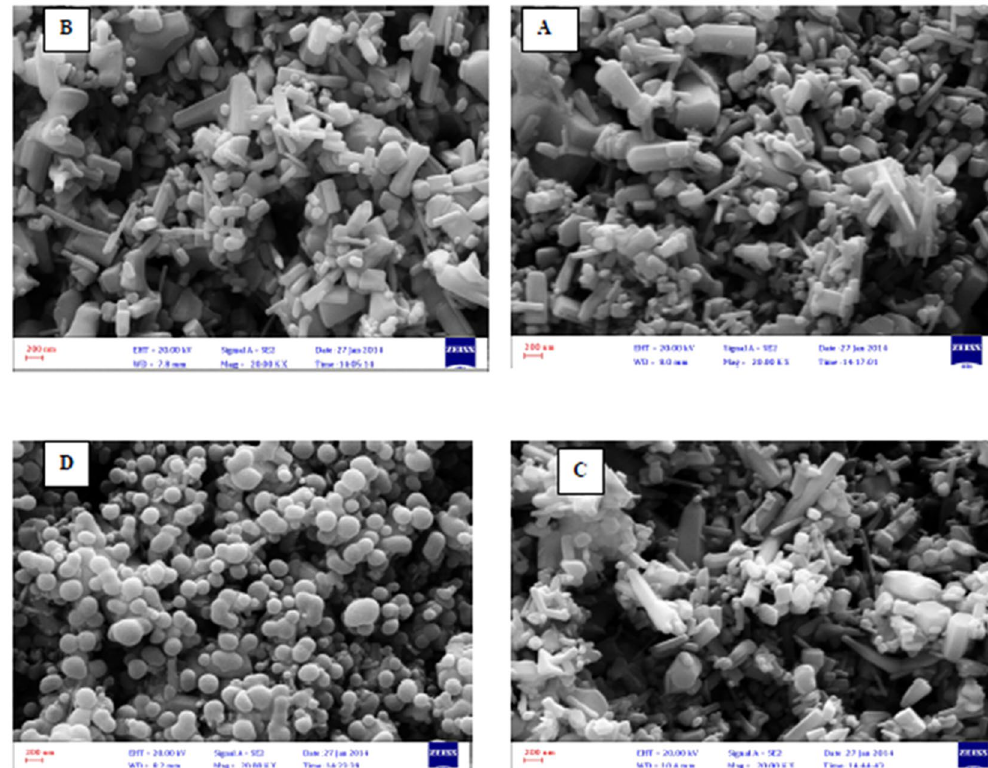
Figure 3. SEM image, ( A ) Powder of zinc oxide nanoparticles doped with chromium oxide; ( B ) A layer of zinc oxide nanoparticles doped with immobilized chromium oxide; ( C ) Three layers of zinc oxide nanoparticles doped with immobilized chromium oxide; ( D ) Zinc oxide nanoparticles doped with immobilized chromium oxide after the photocatalyst process.